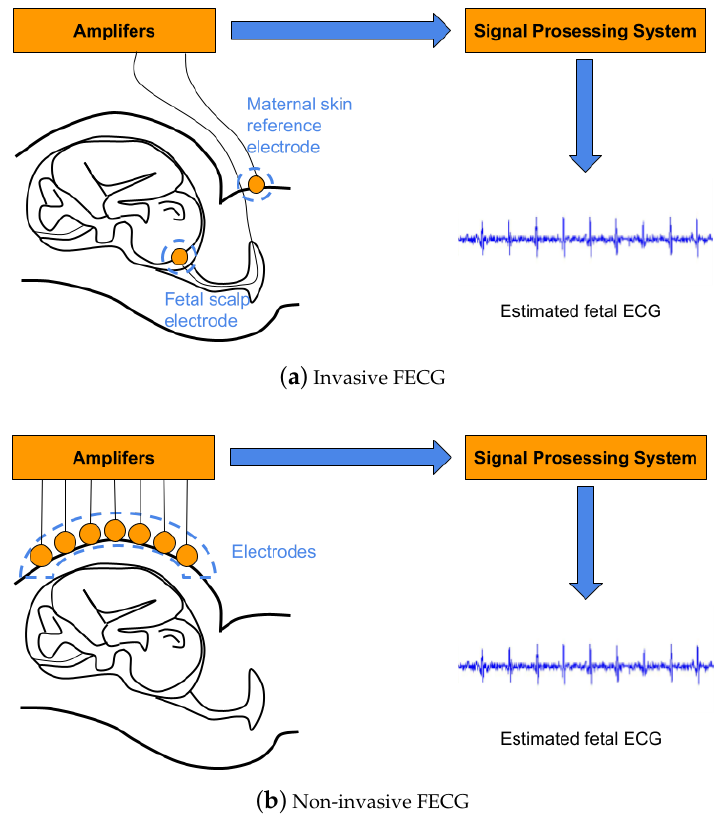
Figure 1. Invasive and non-invasive FECG measurement. ( a ) The invasive FECG signals are extracted by placing the electrode on the scalp of a fetus. ( b ) The non-invasive FECG signals are recorded from the electrodes placed on the maternal abdomen using portable, wearable